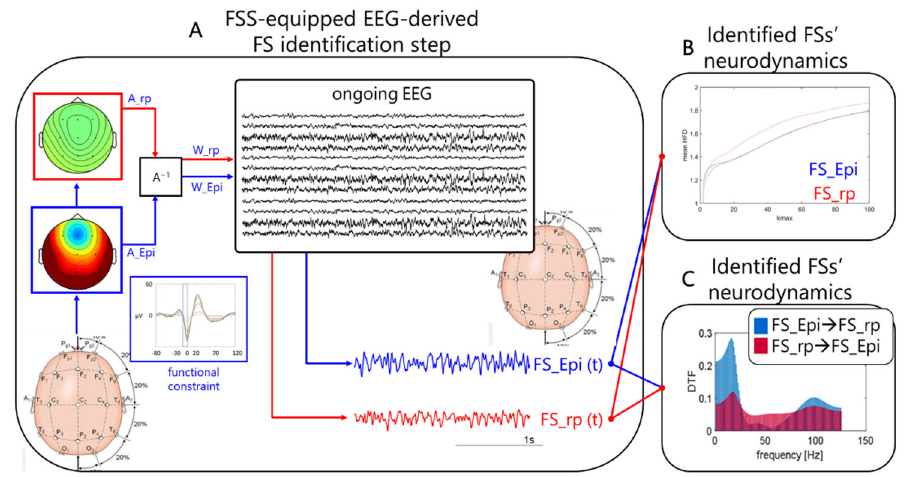
Figure 1. FSS identification step. Obtaining individual FS_Epi and FS_rp neurodynamics in resting states of interest. ( A ) Schematic depiction of how Functional Source Separation (FSS) obtains the functional source describing the epileptogenic network for individual patient and gives access to its activity while he/she was resting with closed eyes (Ongoing electroencephalographic (EEG)). FSS received the EEG data recorded along a sufficient time period for the interictal activity occurring tens of times to identify the SW patterns (functional constrain inset, with the 4 ms time window highlighted) as input and provided the A_Epi as an outcome (which, similar to W_Epi, is a time invariant 19 ‐ dimension vector). The FS_Epi scalp topography derived from A_Epi is shown. FS_Epi(t) in the four conditions of interest (before and after Real and Sham transcranial Direct Current Stimulation (tDCS)) (bottom right traces) is obtained through W_Epi multiplied with the EEG recording at rest in the corresponding condition (central inset). Similarly for FS_rp. From the time evolution of the two sources, we estimate their Higuchi Fractal Dimension (HFD) as a function of Kmax ( B ), and the directed transfer function (DTF) from each of the two on the other ( C ).A − 1 . FS, functional source. 2.1.2. Higuchi Fractal Dimension (HFD) of the Identified FS(t) Many previous studies demonstrated that a simple method of nonlinear dynamics like Higuchi fractal dimension (HFD) [1,2,7,27–31] is very efficient in analysis of neuro ‐ dynamics complexity [32]. In this study (Figure 1B), HFD was applied to evaluate the impact of tDCS on FS_Epi complexity and on the complementary network (FS_rp). HFD was calculated in one ‐ second non ‐ overlapping windows and averaged over all windows along the about 15 min of EEG recordings in each of the four conditions (see Figure 1). To select the k max parameter, the HFD was calculated in the range from 1 to 100 and the value to 40 was chosen. 2.1.3. Connectivity Analysis between Identified FSs(t): Directed Transfer Function (DTF) A connectivity analysis between the FS_Epi and the residual FS_rp networks was performed by Directed Transfer Function (DTF) [33]. DTF is a directed and multivariate connectivity method defined in the frequency domain [34,35] that allows for estimation of causal influences between involved networks in a given frequency band. The multi ‐ variate approach permits for elimination of spurious connections. To optimize the DTF calculation (Figure 1C), FS_Epi and FS_rp were down ‐ sampled to 250 Hz and windowed in 20 ‐ s segments along the approx. 15 min of EEG recordings in